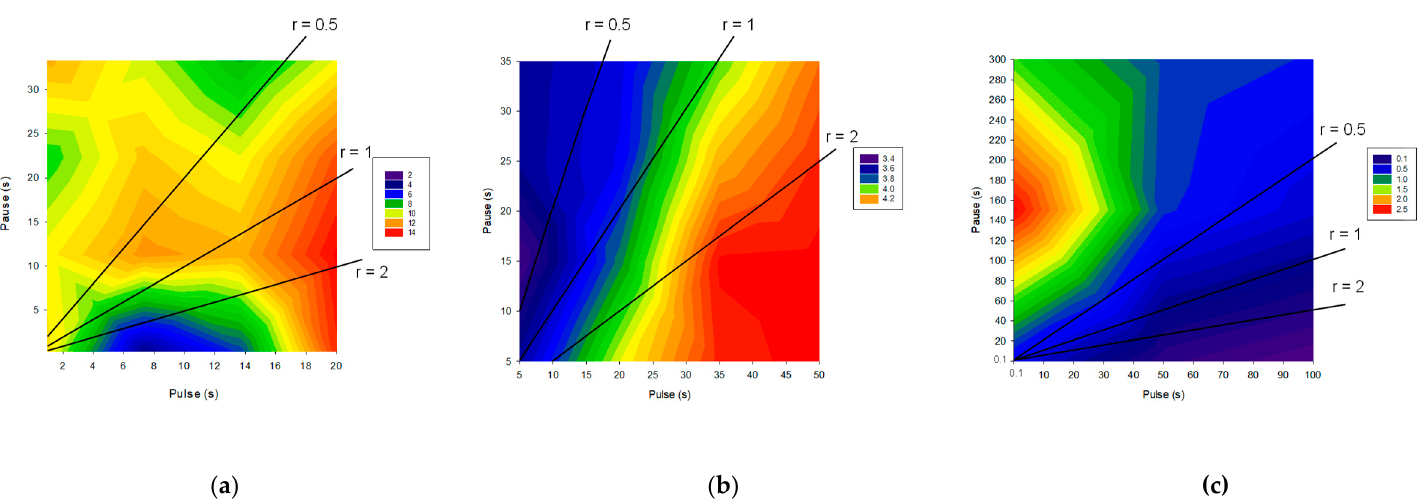
Figure 14. Two-dimensional contour plots of relative energy consumption (Wh/1000 C) as a function of pulse and pause durations for ( a ) demineralization of model salt solution (adapted from [66,110–112]; ( b ) demineralization/lactic acid recovery of acid whey (adapted from [83,113] and ( c ) demineralization of polymer-flooded produced water (adapted from Sosa-Fernandez et al. [84]. r = pulse duration/pause duration ratio.